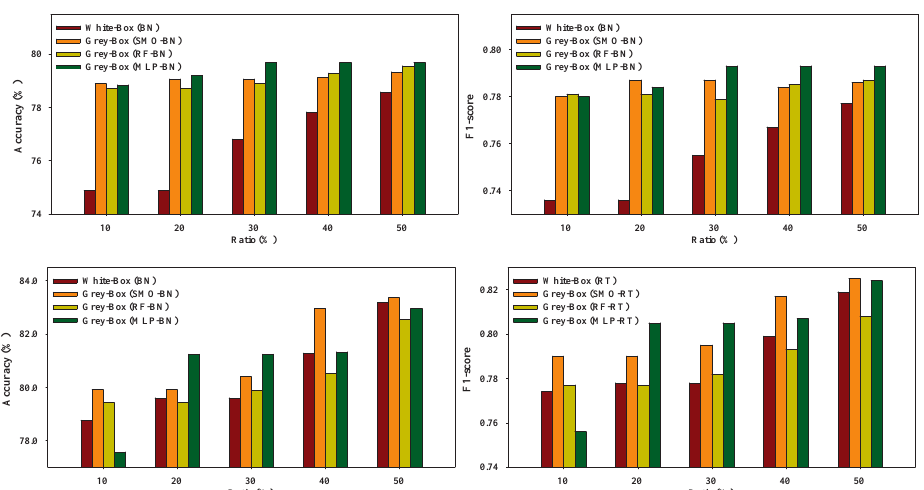
Figure 4. Box-plot with performance evaluation of Grey-Box and White-Box models for EduDataAB dataset.